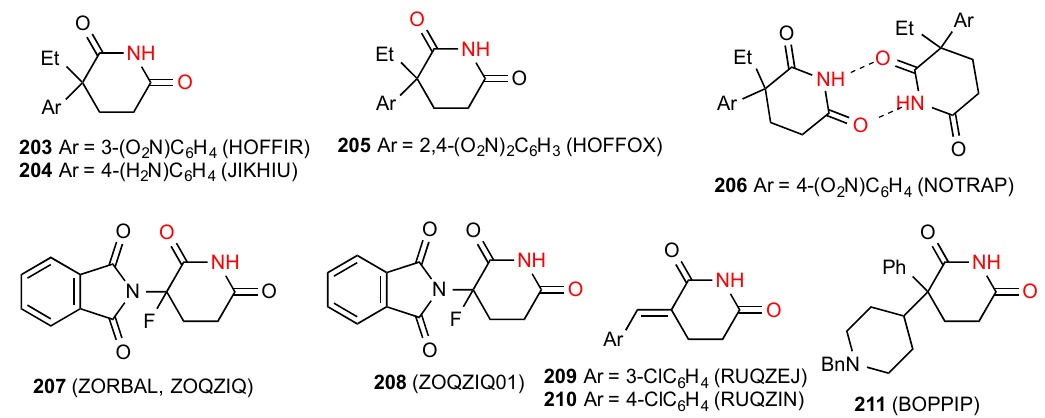
Figure 63. 3,3-Disubstituted glutarimides structures of pattern A or B.